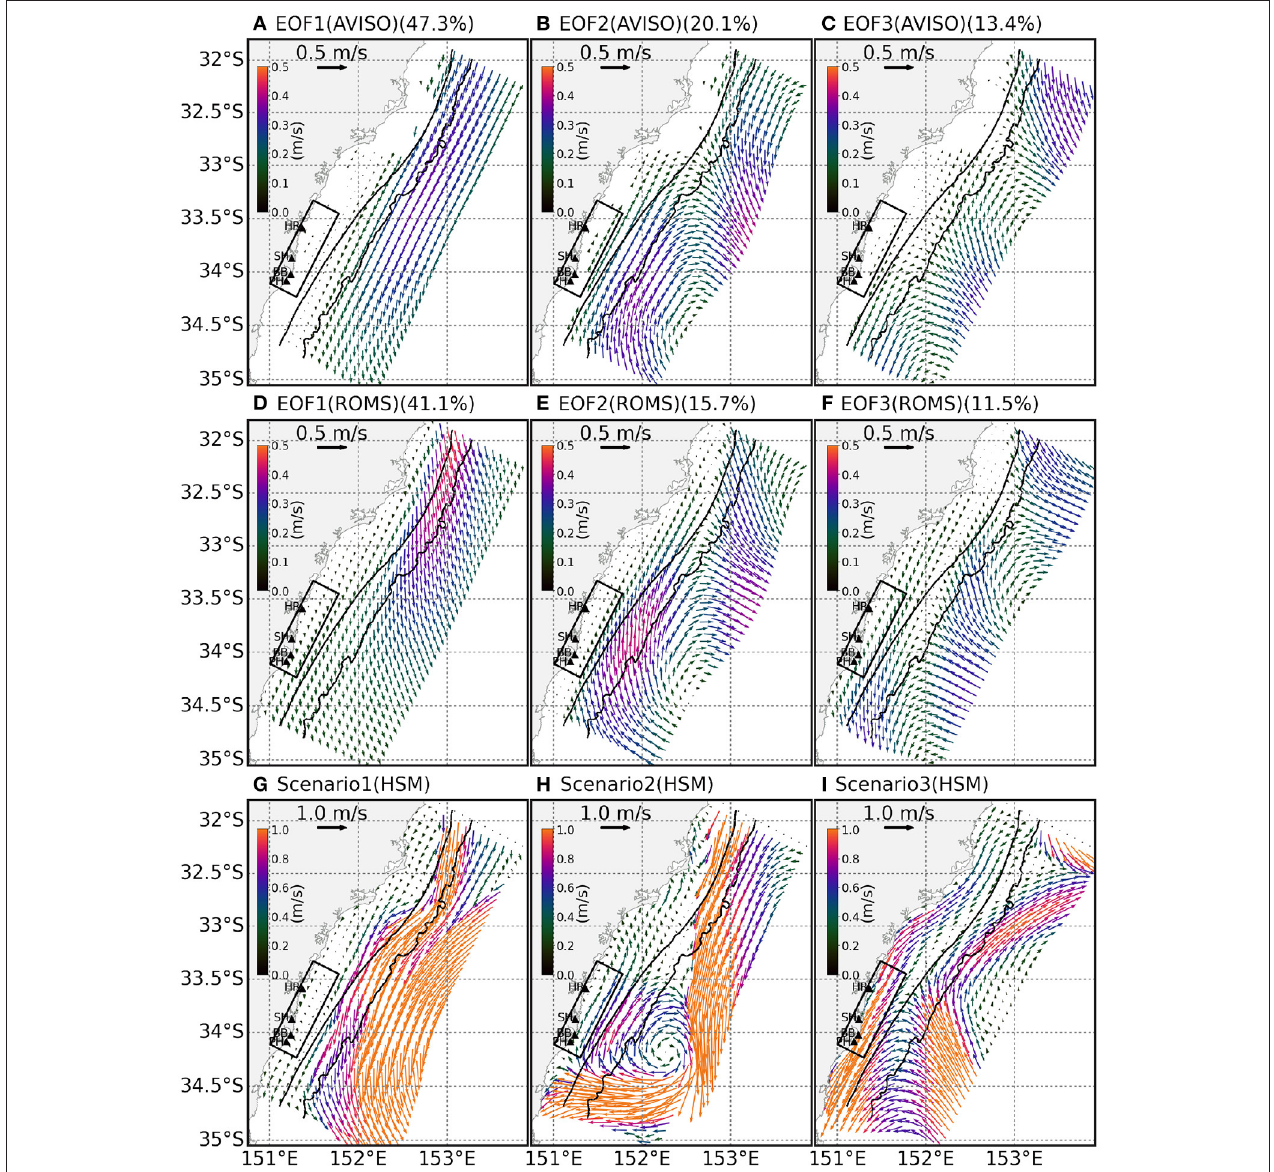
FIGURE 2 | EOF analysis of daily velocities from the EAC-ROMS simulations and AVISO observations for the period of 1994–2019, and mean velocities of the chosen EAC scenarios from the HSM model simulations. (A–C) Spatial patterns of the three dominate EOF modes in geostrophic velocities from AVISO observations. Percentages of the explained variances for each mode are indicated. (D–F) Same as (A–C) , but for surface velocities from the EAC-ROMS simulations. Panels (G–I) show the snapshots of the mean circulation patterns in the HSM model that reproduce each EAC scenario as shown in the EOF